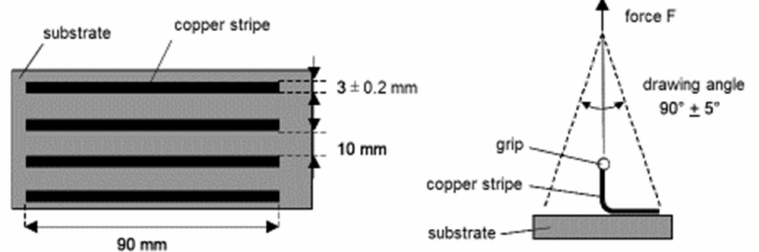
Figure 2. Essentials of the peel test. Geometry of the test samples ( left ) and sketch of the test procedure ( right ).